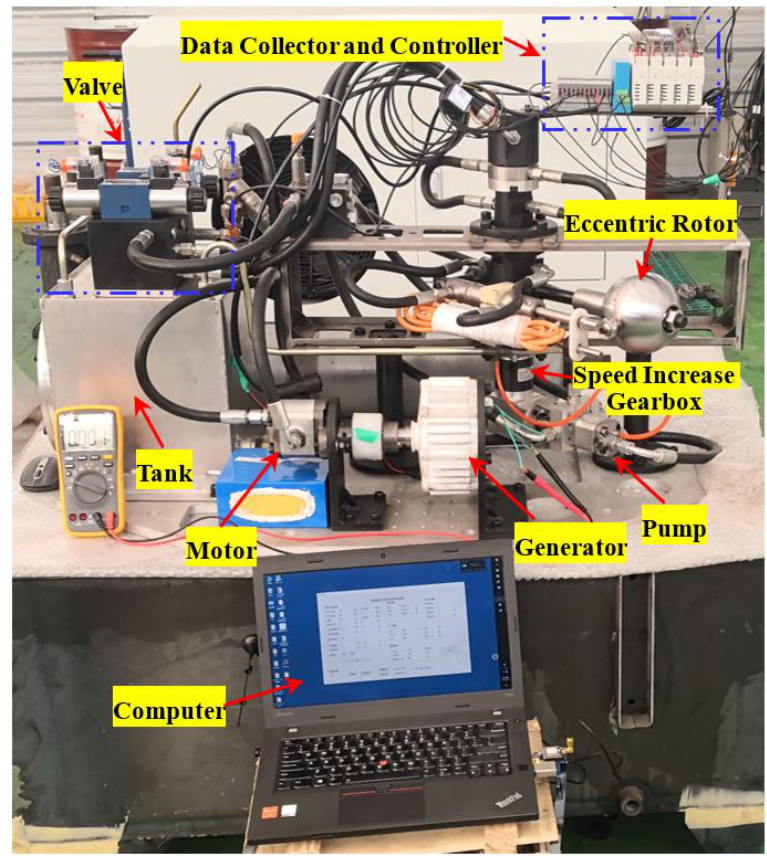
Figure 3. Physical model of hydraulic PTO system.